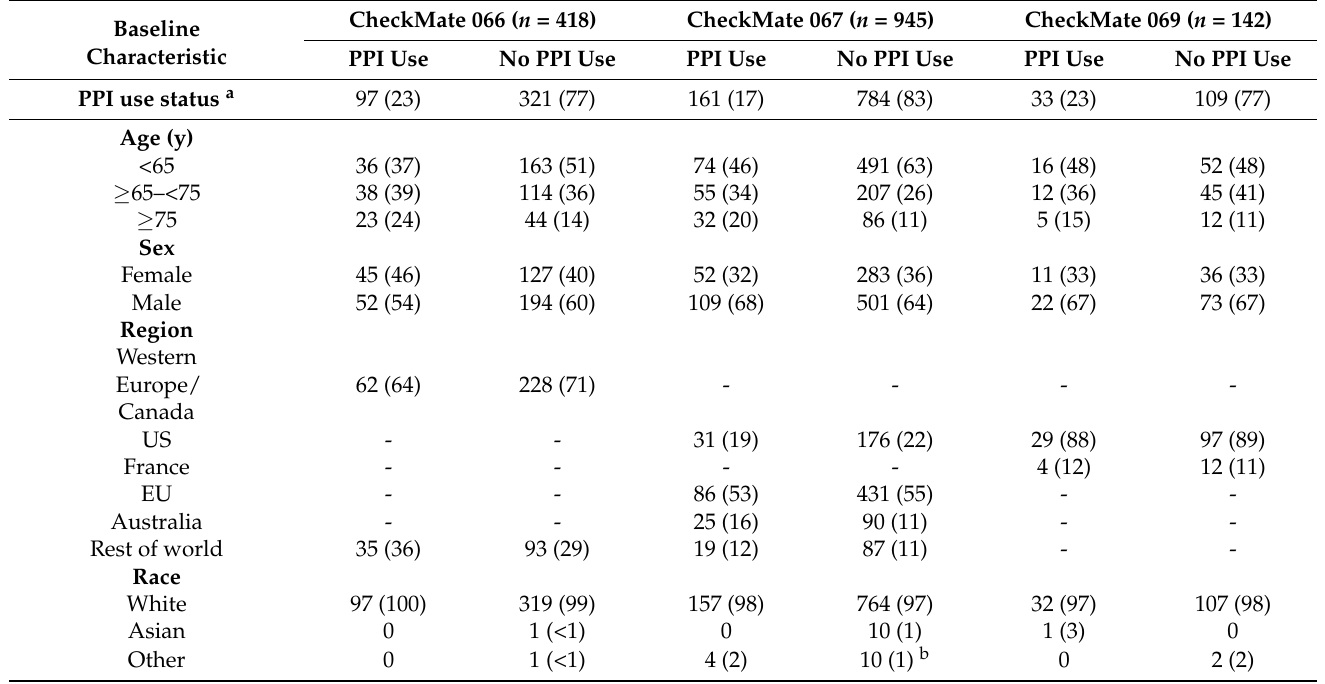
Table 2. Baseline characteristics by PPI usage in CheckMate 066, 067, and